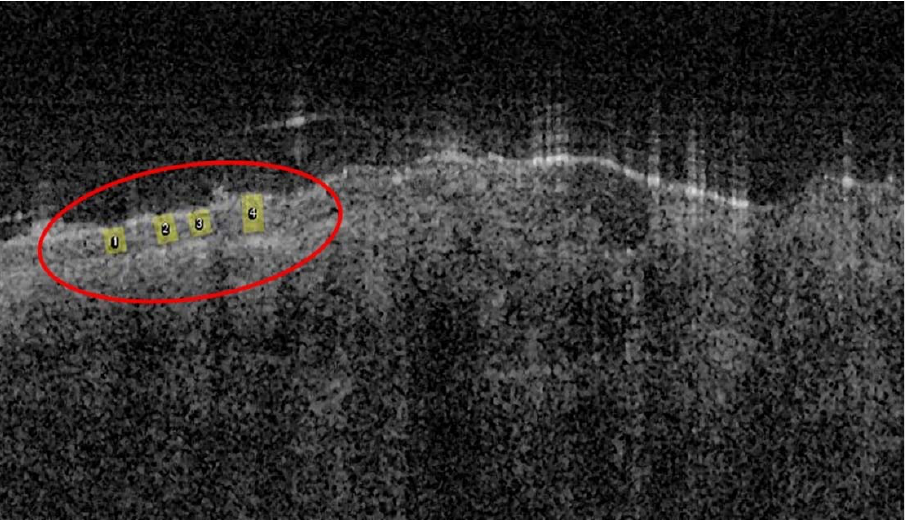
Figure 1. Representative OCT image acquired from the forearm of a healthy volunteer with four ROIs (highlighted with yellow in the red ellipse).